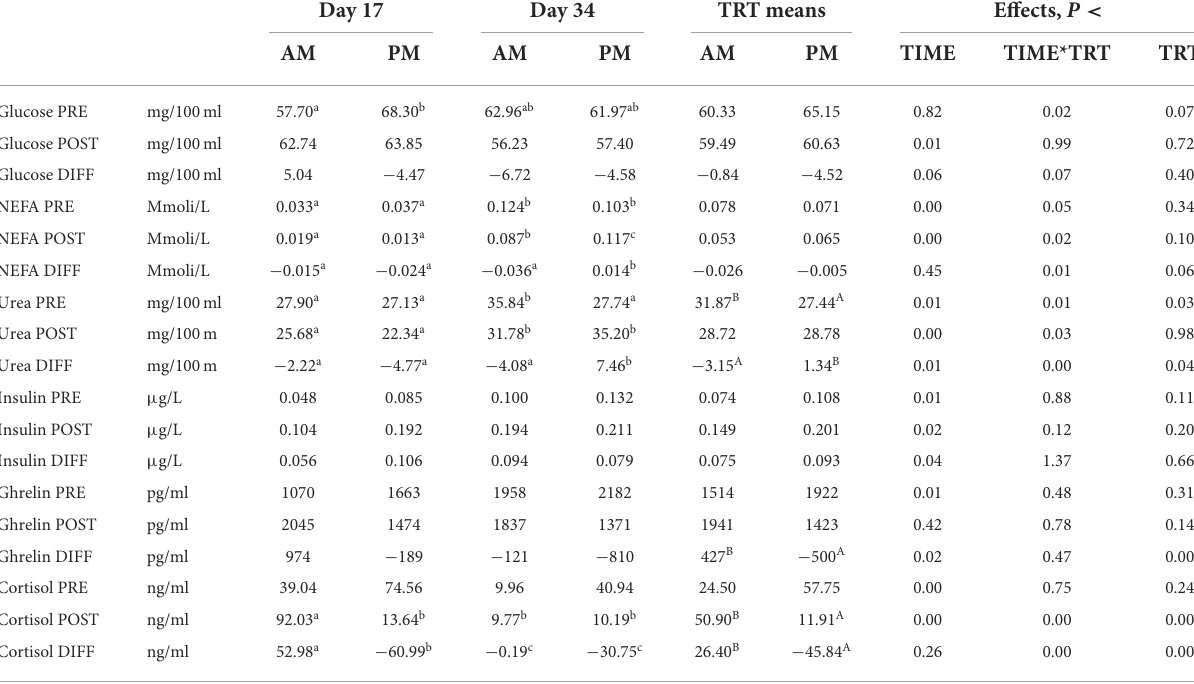
TABLE 3 Effect of the timing of pasture allocation on blood metabolites and hormones pre- (PRE) and post (POST) grazing and their changes (DIFF = POST-PRE) during the grazing sessions on two sampling days (day 17 and day